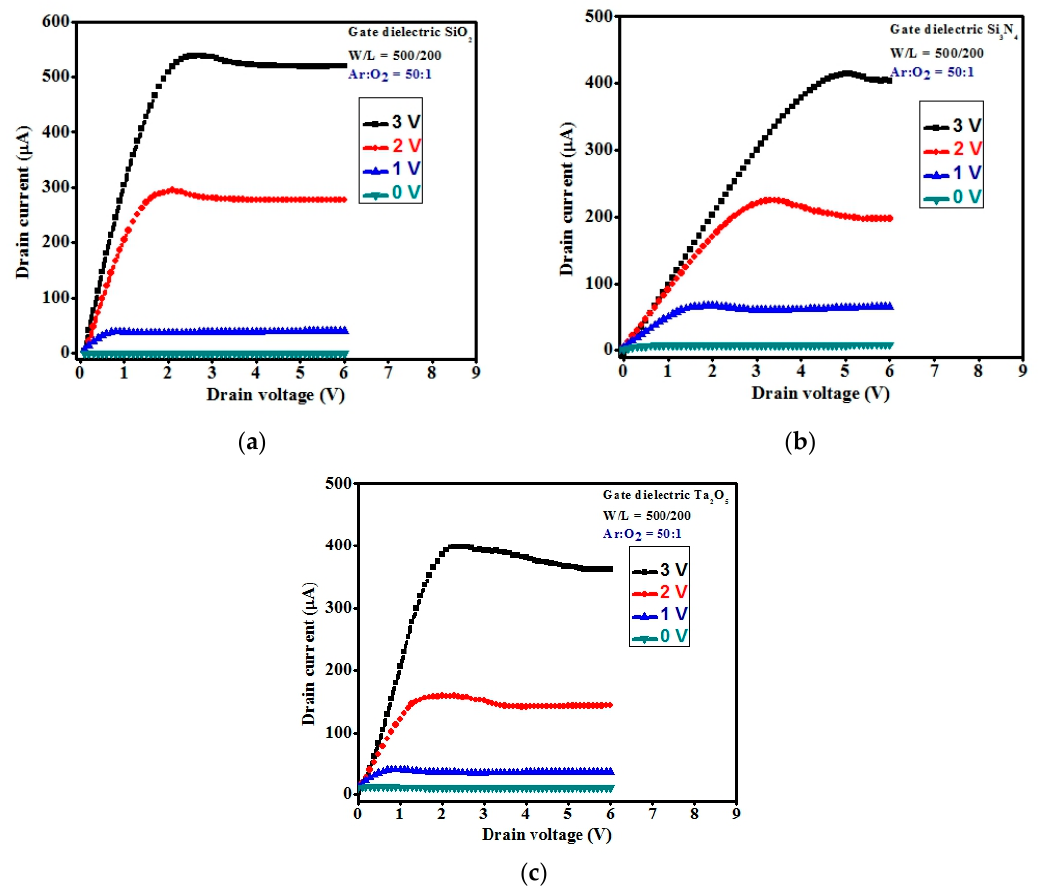
Figure 10. The output characteristics of the a -IGZO TFTs with different gate dielectric ( a ) SiO 2 , ( b ) Si 3 N 4 , and ( c ) Ta 2 O 5 at channel width of 500 µ m. The gate voltage varied from 0 V to 3 V with an increased step voltage of 1 V.